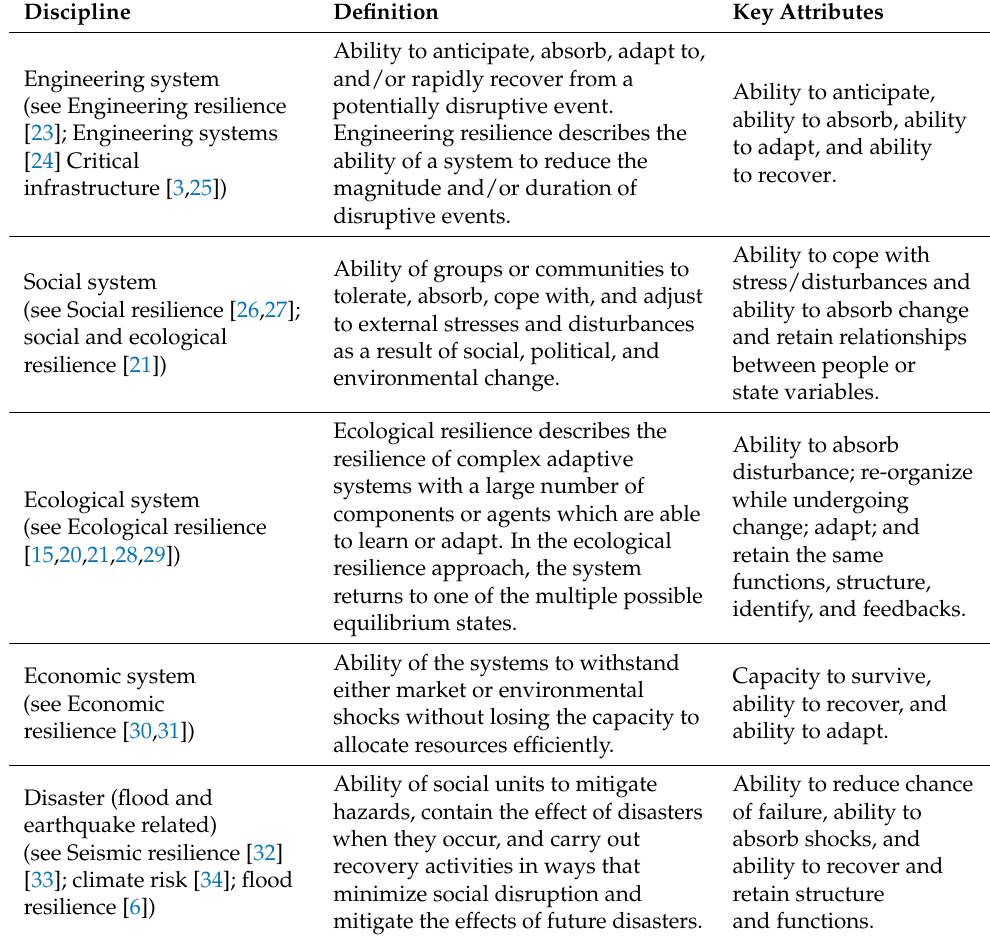
Table 1. Definition of resilience in different